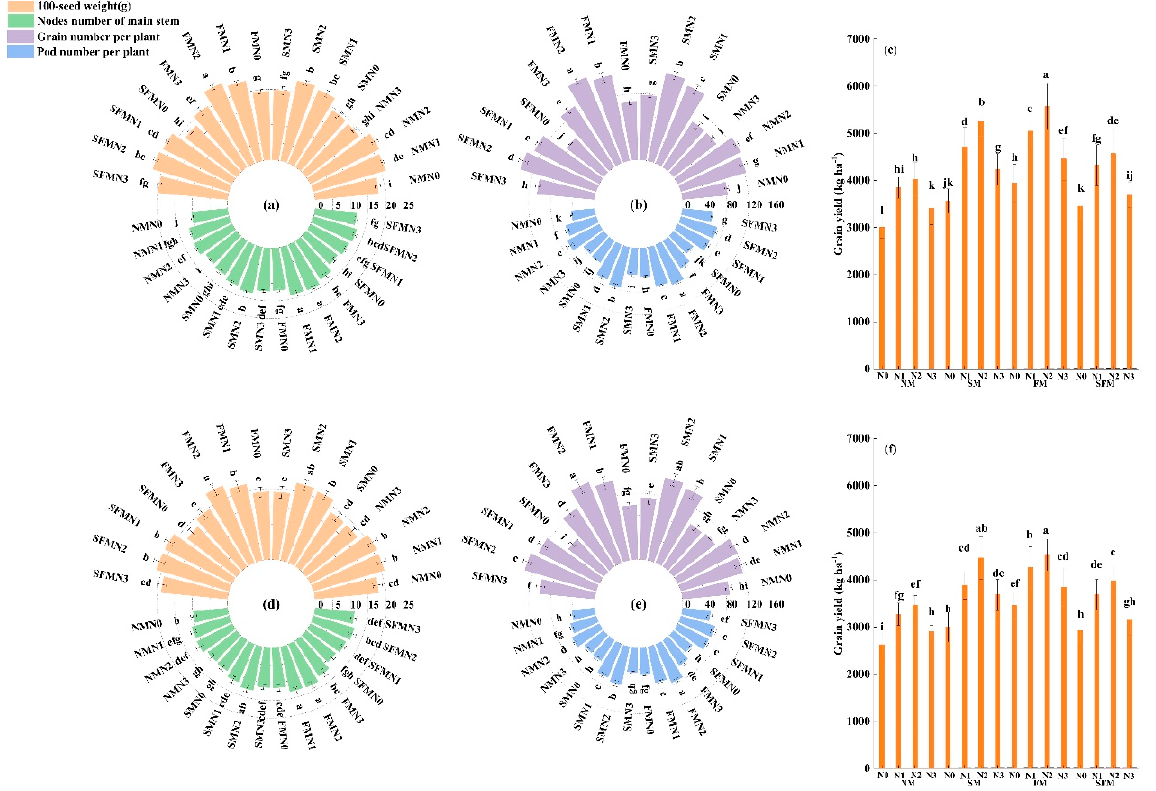
Figure 5. Effects of nitrogen application and mulching treatments (NM, SM, FM, SFM) on soybean yield and its components in 2021 and 2022. ( a – c ) represent the data for 2021, and ( d – f ) represent the data for 2022. The vertical line represents the LSD value at the p = 0.05 level. Different lower cases indicate significant differences among treatments.